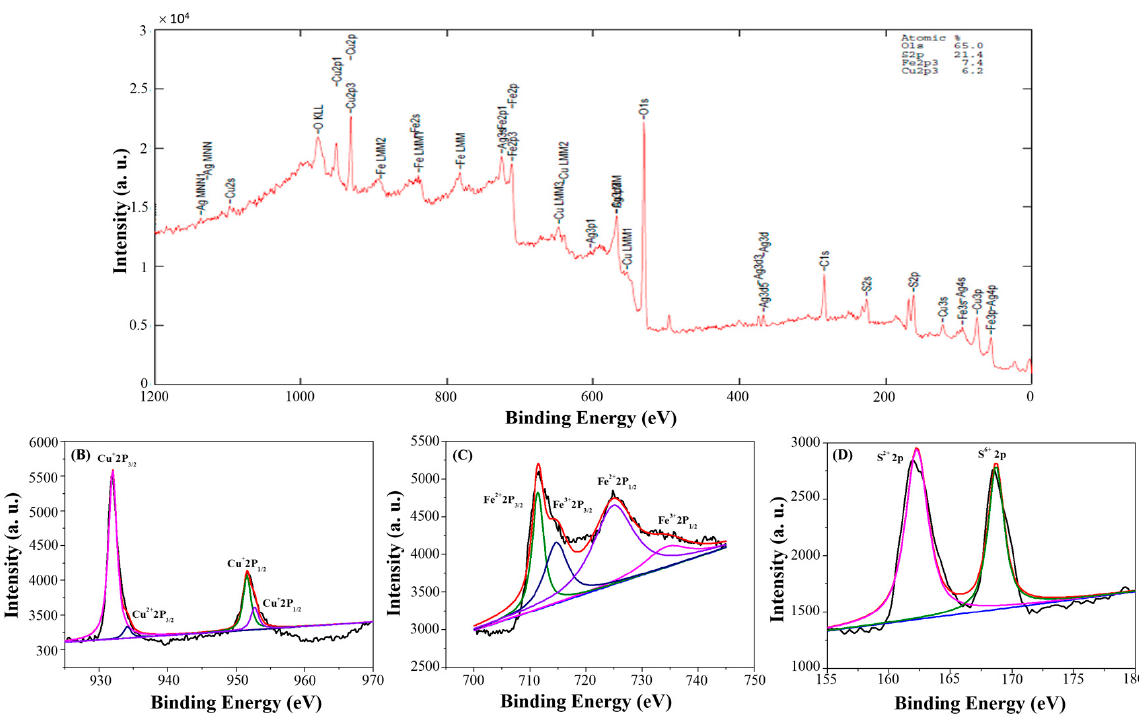
Figure 6. XPS spectra of C-CuFeS 2 samples: ( A ) full scan, ( B ) Cu 2p , ( C ) Fe 2p , and ( D ) S 2p